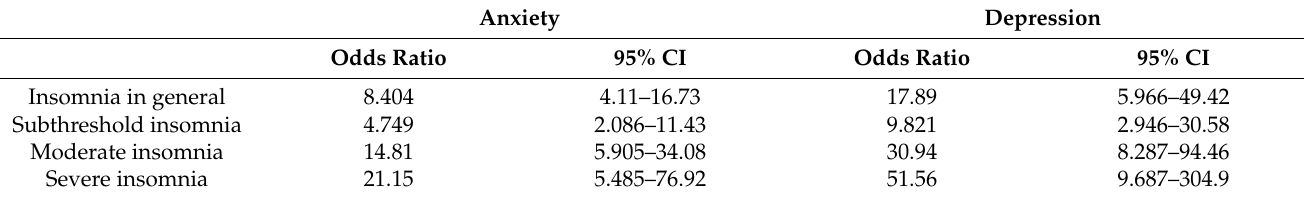
Table 3. Odds ratios for the different psychiatric disorders analysed associated with the various degrees of insomnia. The data were